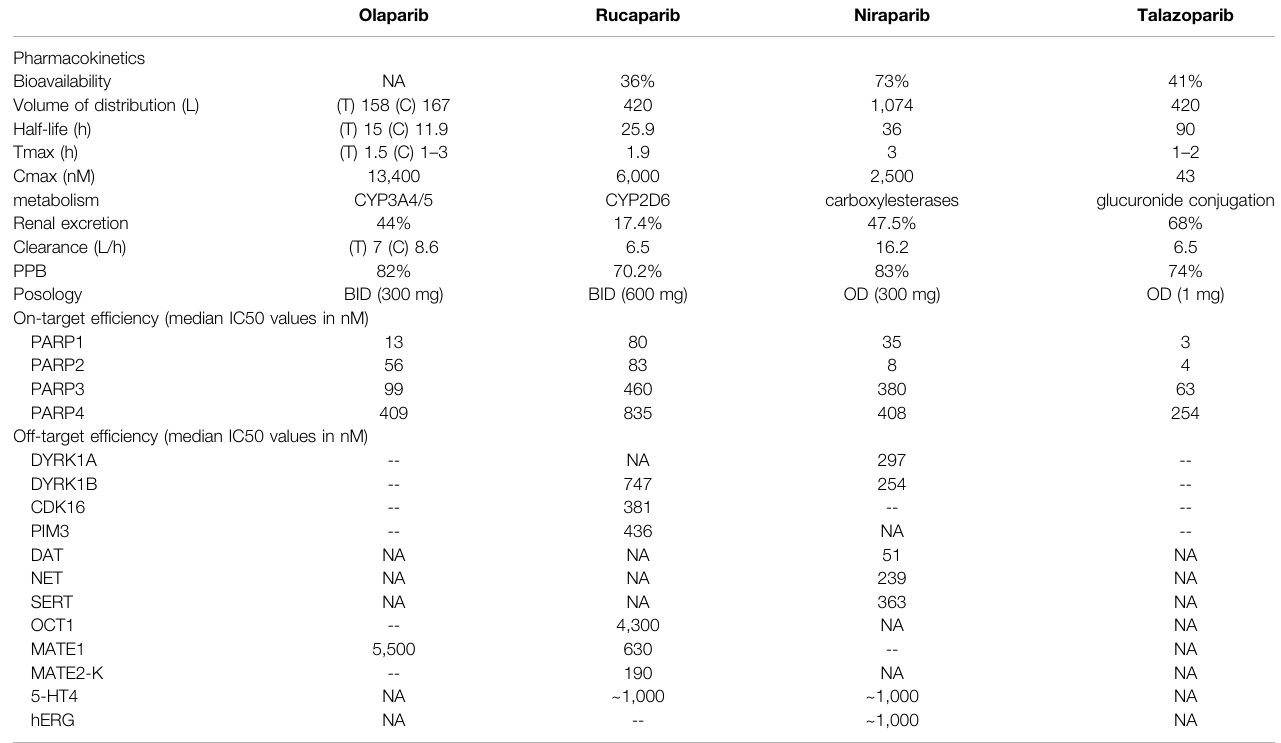
TABLE 5 | Pharmacological properties of the four